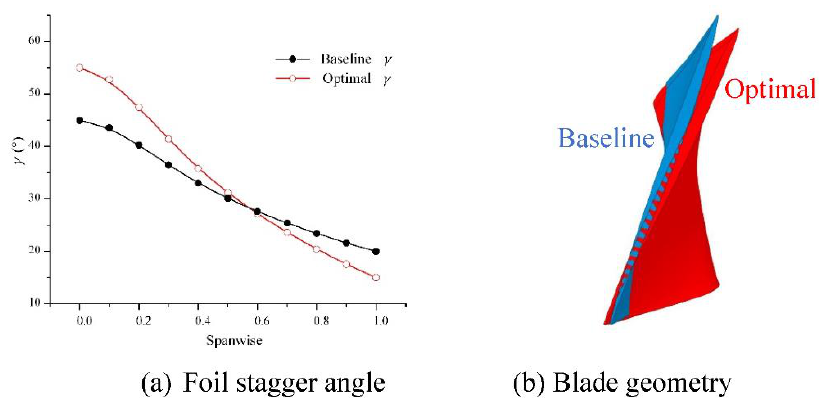
Figure 8. Comparison between the baseline pump and optimal pump.